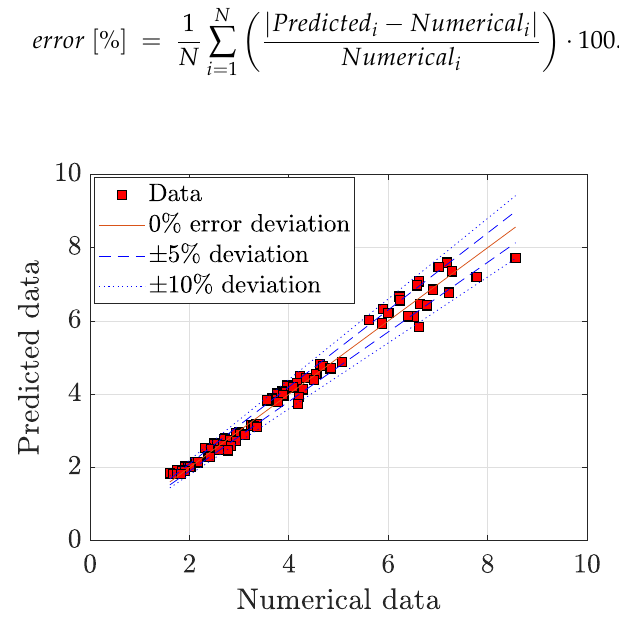
Figure 14. Fitting model for P p